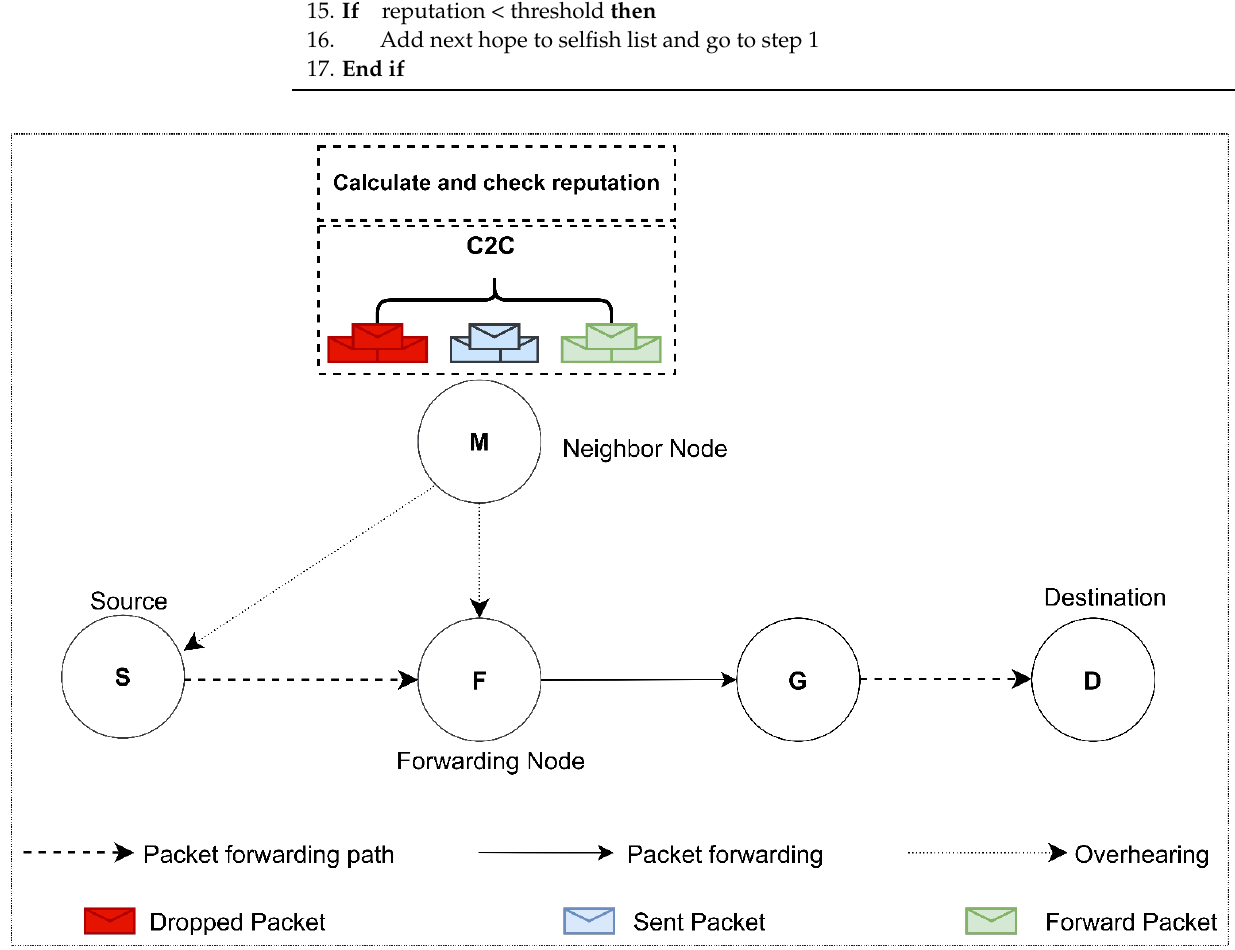
Figure 1. Illustration of the proposed scheme, where nodes monitor the C2C of other nodes and calculate the reputation accordingly.